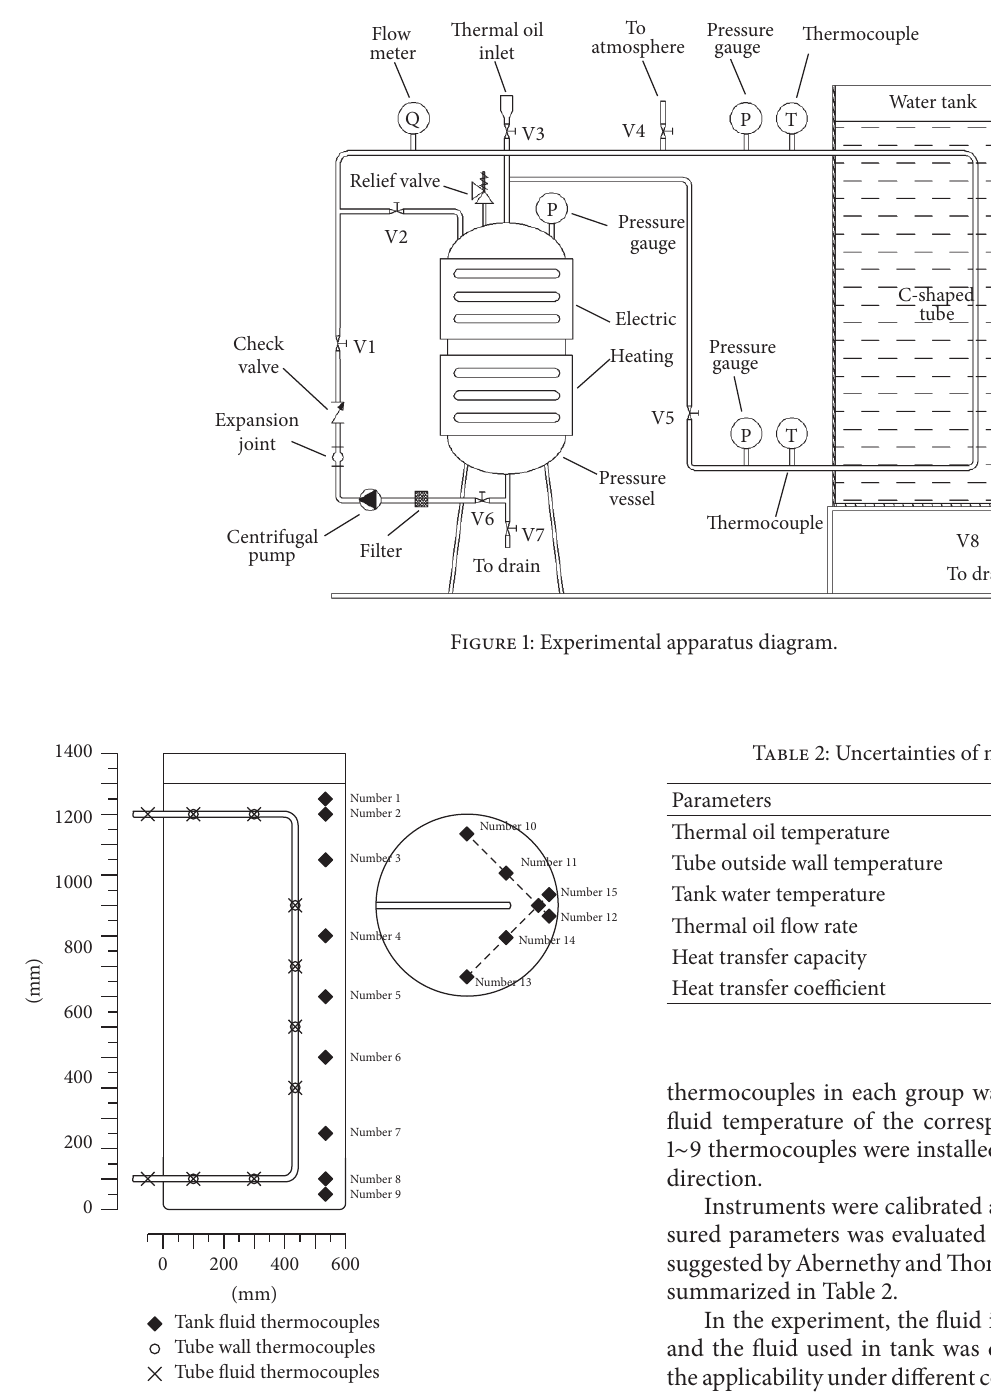
Figure 2: Water tank and thermocouple layout.